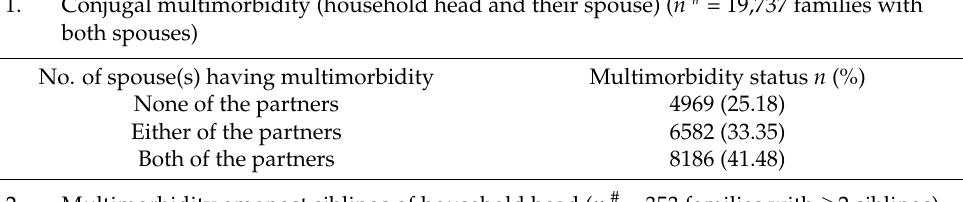
Multimorbidity amongst siblings of household head ( n # = 353 families with ≥ 2